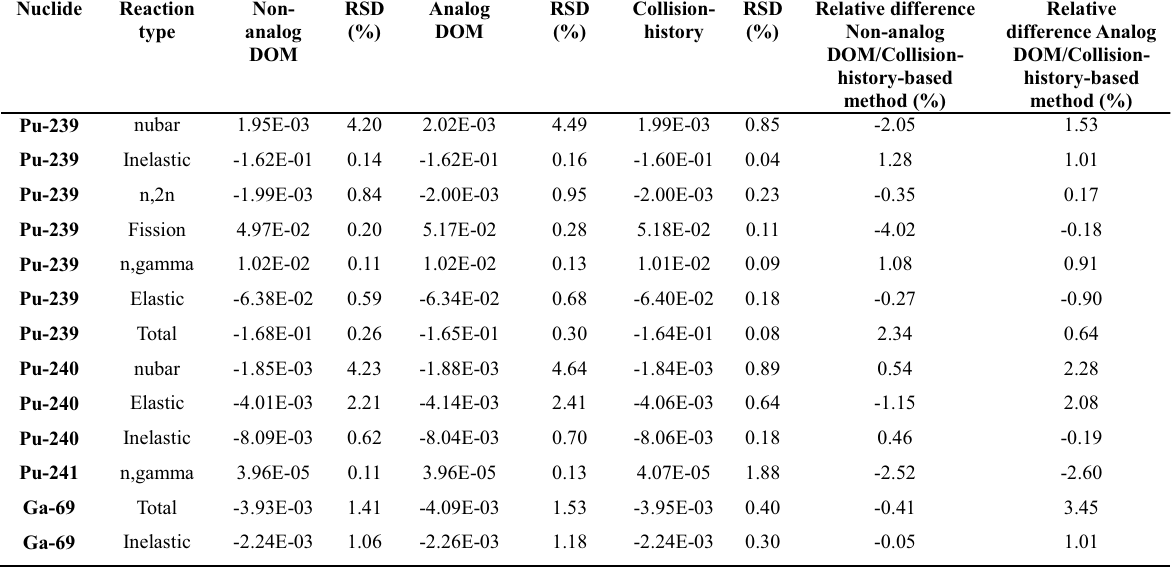
Table I. Sensitivity coefficients for the Jezebel